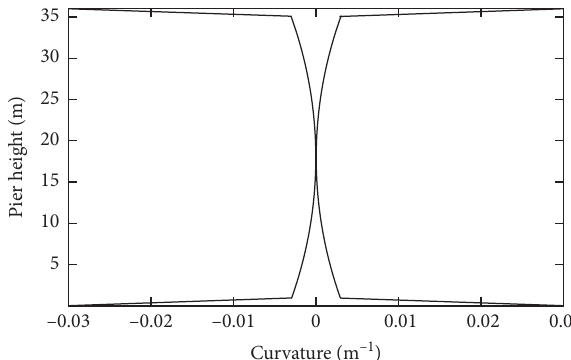
Figure 2: Curvature envelope of rigid frame pier section along